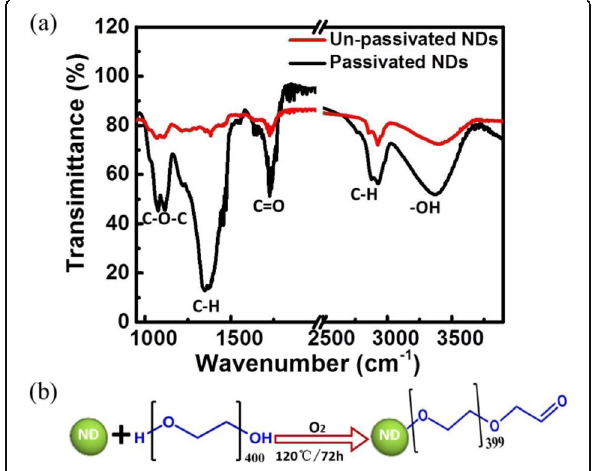
Fig. 3 ( a ) FTIR spectra of un-passivated and passivated NDs. ( b )